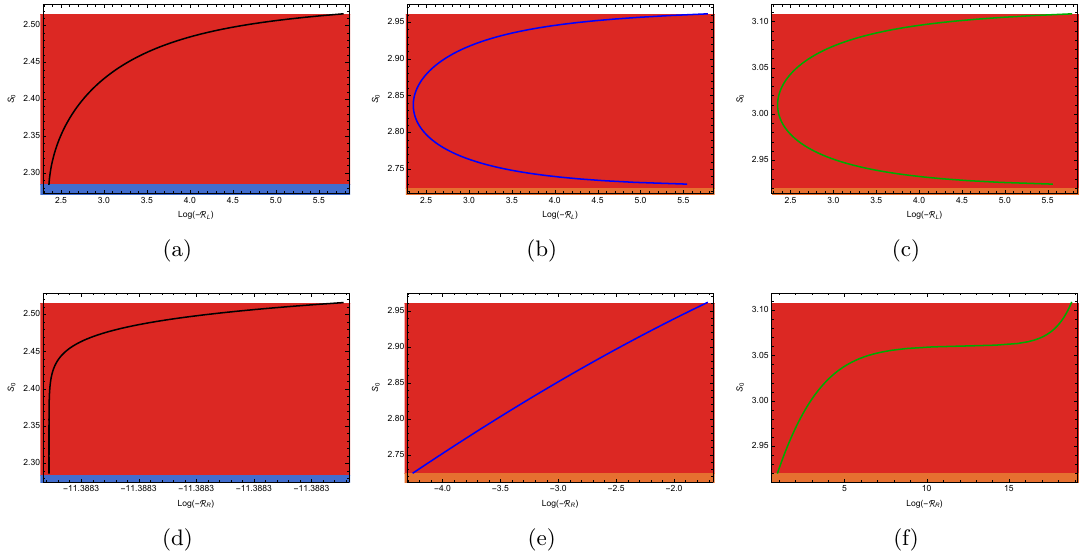
Figure 31 . The dimensionless curvatures vs S 0 for three generic cases, ϕ 0 = 3 . 25 (a) and (d) diagrams, ϕ = 4 (b) and (e) diagrams and ϕ 0 (b) or (f) and (e) we observe that the qualitative features of the e and therefore we should be interpret them as a single